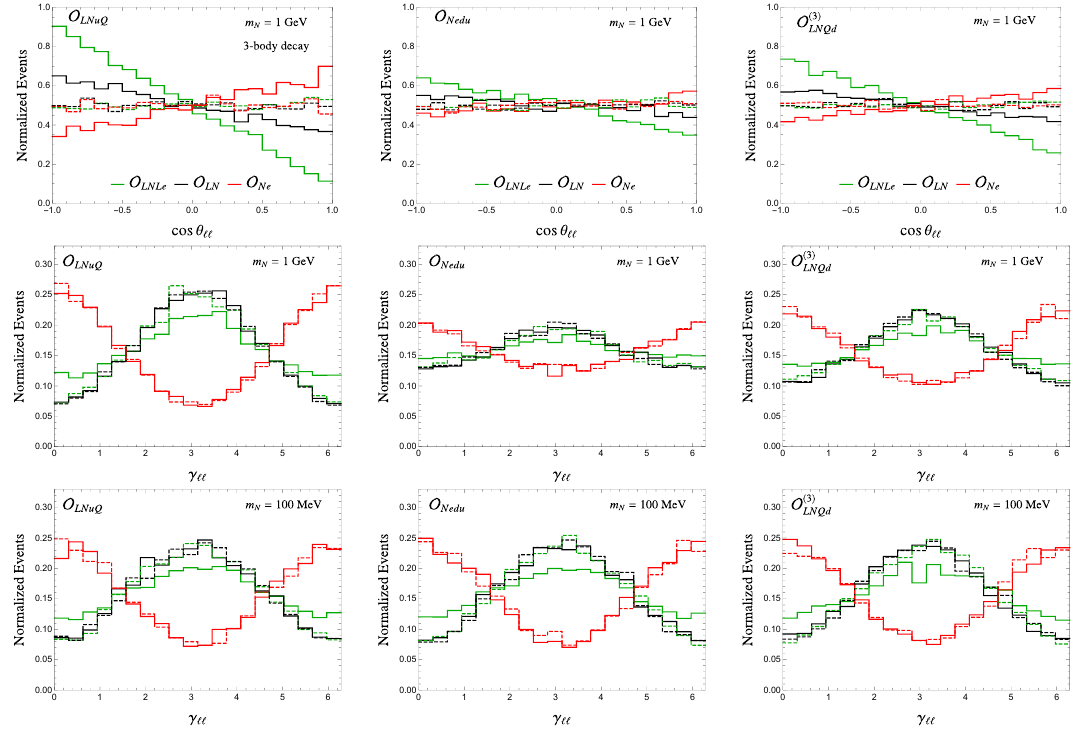
Figure 11 . Smeared cos θ ‘‘ distributions (upper panels) and γ ‘‘ distributions (middle and lower panels) from three-body B decay for the three production operators, and three decay operators: O LNLe (green), O LN (black), O Ne (red) for DF (solid lines) and MF (dashed